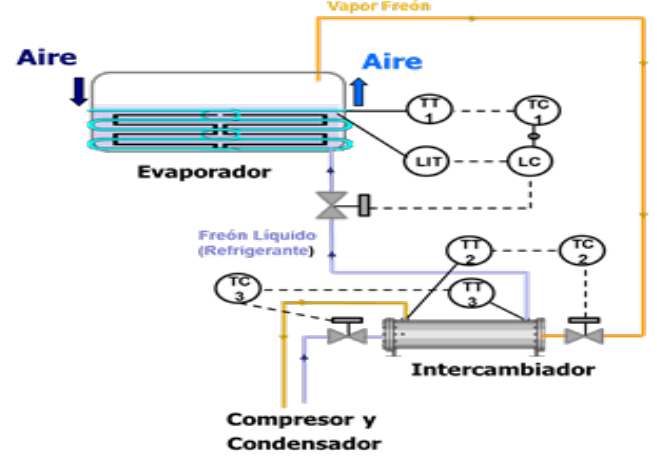
Figura 9: Conexión entre el intercambiador de calor y el